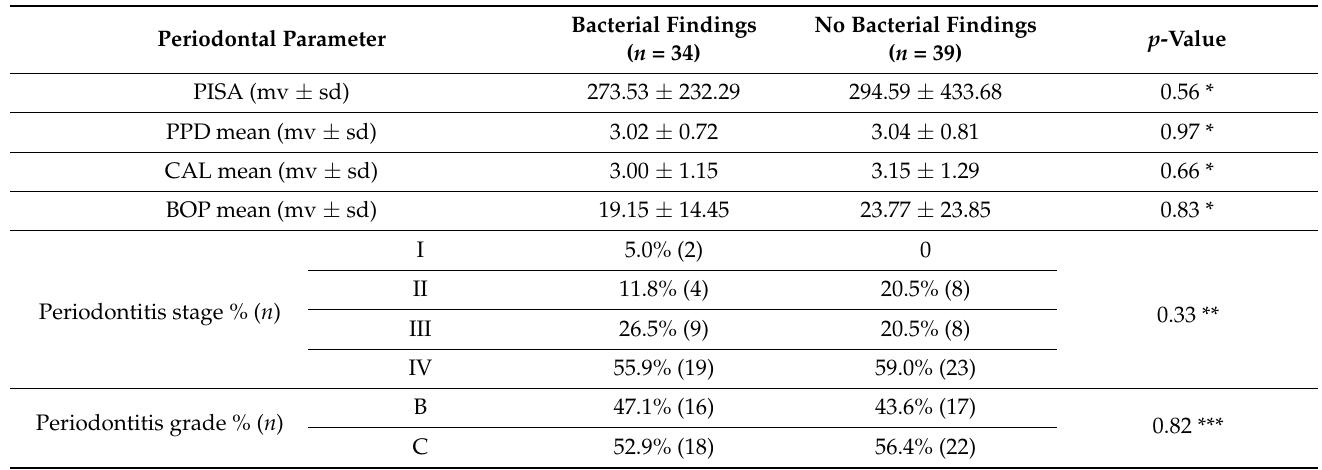
Table 5. Association between bacterial findings on the day of oral examination and periodontal health parameters. Periodontal Parameter